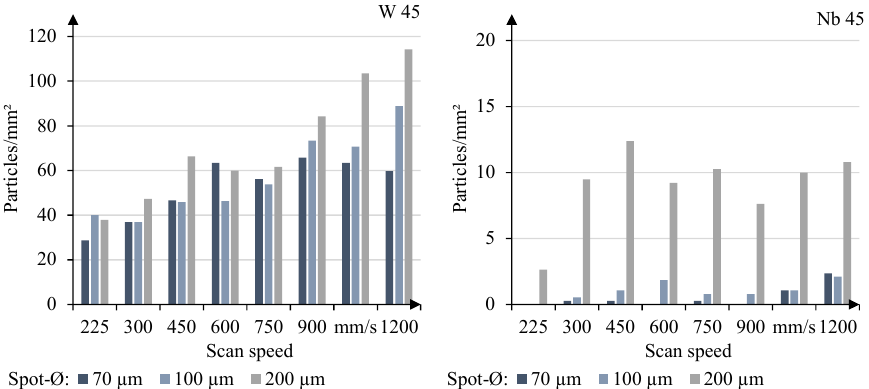
Figure 4. Results of experiment series 1 (see Table 2); constant volumetric energy density (55.6 J/mm 3 ), laser power scales with scan speed.